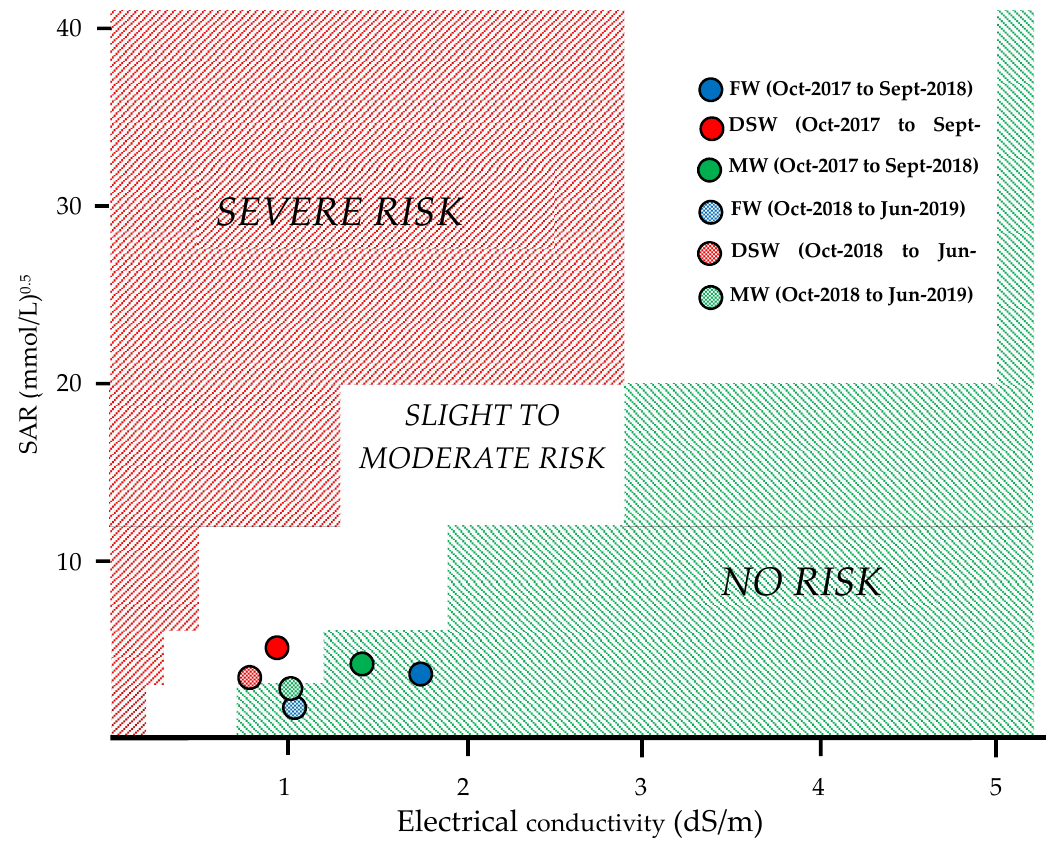
Figure 2. Soil sodicity potential risk evaluated using the sodium adsorption ratio (SAR w ) and the electrical conductivity (EC w ) of the irrigation water in the three irrigation treatments (fresh water; FW, desalinized seawater; DSW, and mix water; MW).